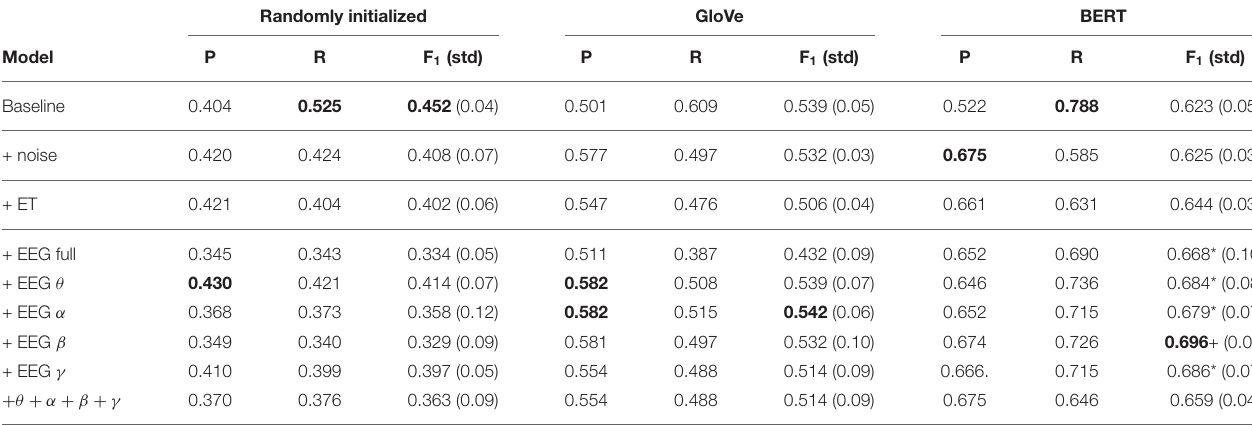
TABLE 6 | Relation detection results of the multi-modal model using the recurrent EEG decoding component . Randomly initialized GloVe BERT